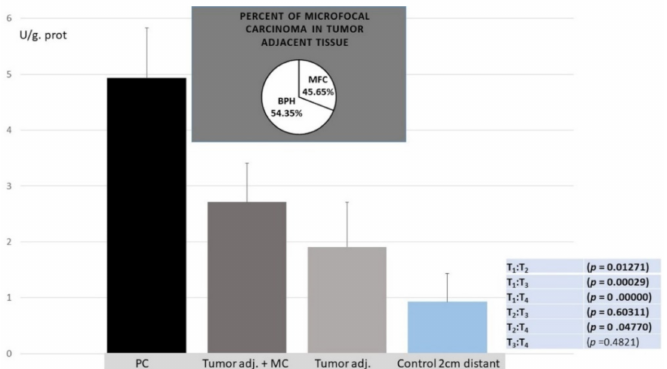
Figure 1. Poly(A) deadenylase specific enzyme activity (U/L g.prot) in PC, tumor adjacent with MC, tumor-adjacent and control healthy counterparts.